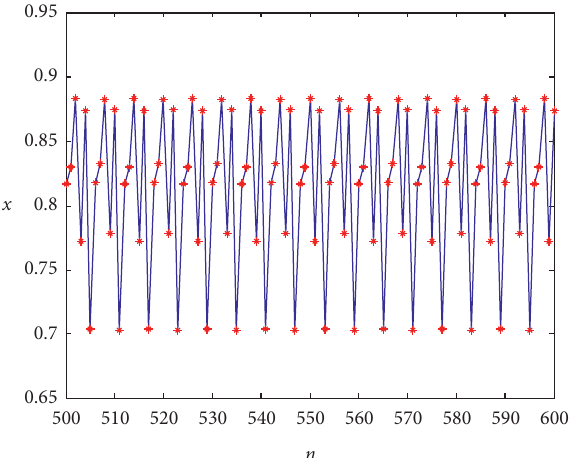
Figure 7: y-z phase diagram which denotes that the system is chaotic when α � 0.05.